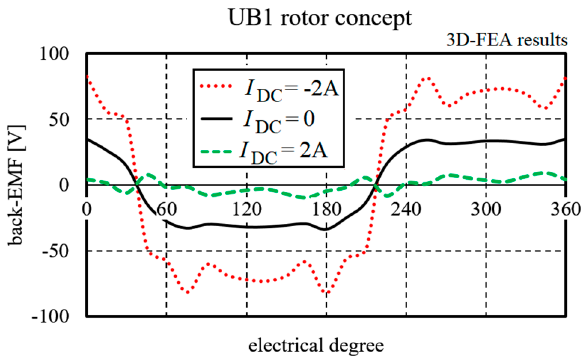
Figure 5. Back-EMF waveforms at different DC field excitation for the UB1 rotor concept. Additionally, FE analysis of the electromagnetic torque ripple (Figure 6) and cogging torque (Figure 7) at different DC field excitations has been carried out.